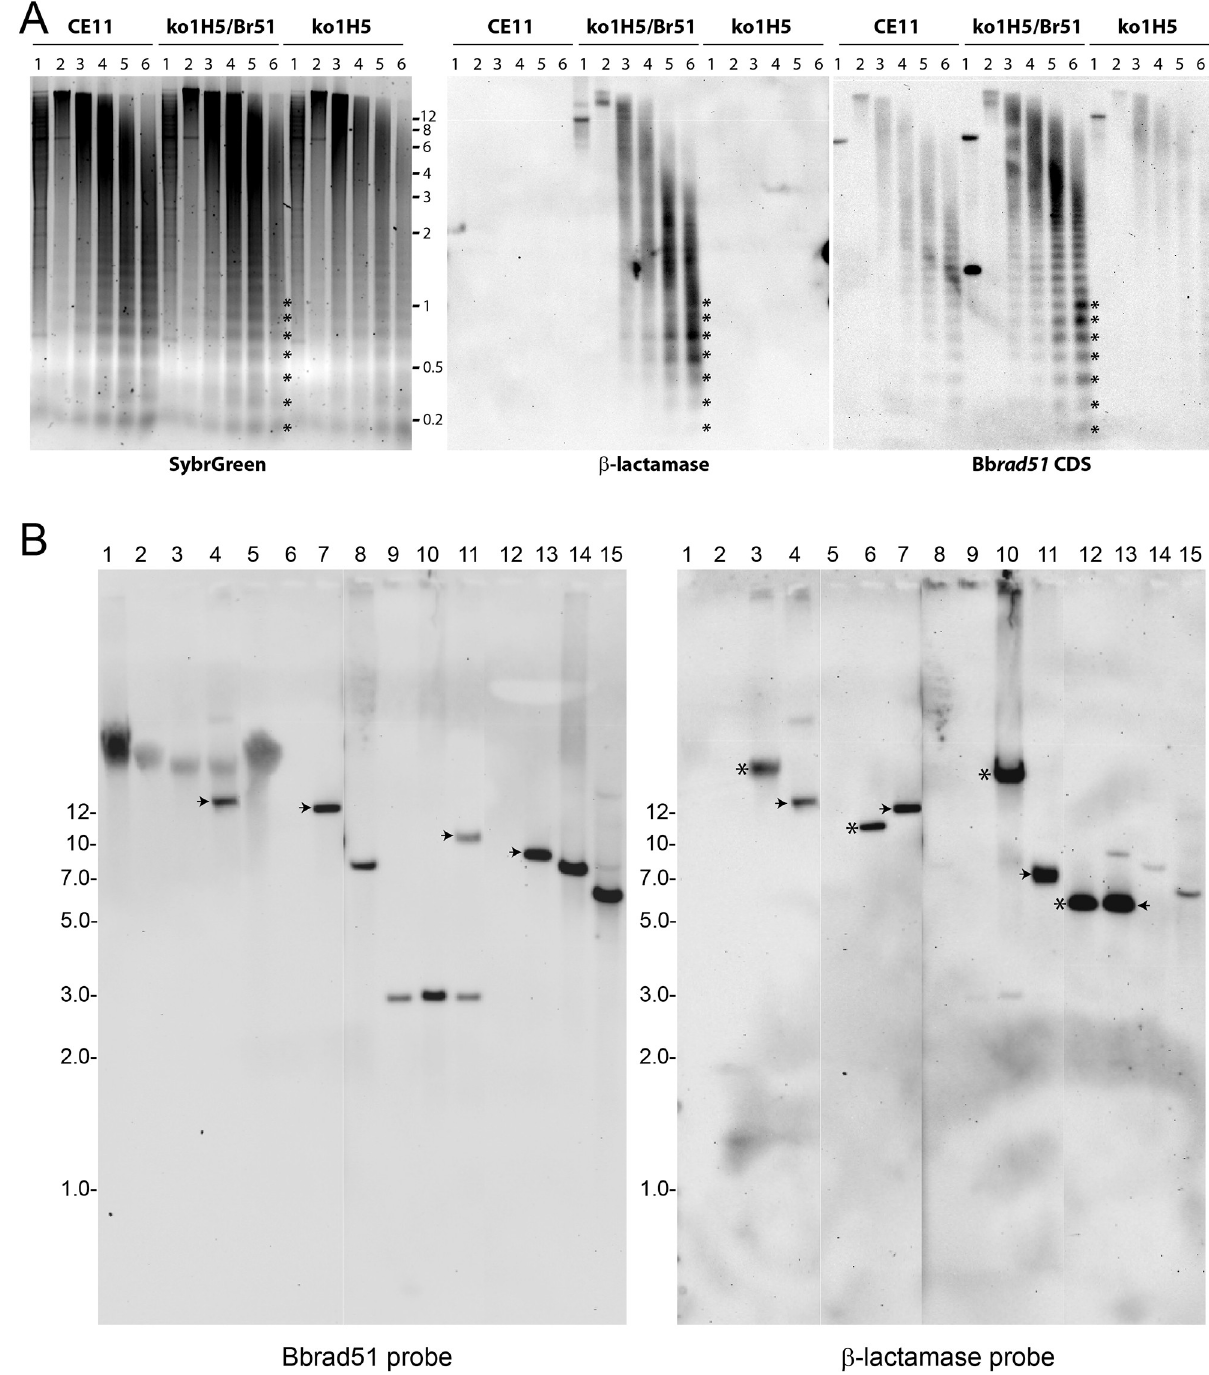
Fig 7. Assembly of BbACc3_Bb rad51 wt into chromatin. Isolated parasite nuclei were subjected to digestion with titrated concentrations of MNase, then Southern-blotted and probed with different sequences. A. (left panel) SybrGreen-stained agarose gel of MNase partially-digested genomic DNAs from B . bovis CE11 wild-type (CE11), ko1 H5/BbACc3_Bb rad51 wt ( ko1 H5/Br51), and ko1 H5 Bb rad51 knockouts ( ko1 H5). Lanes are: (1) PstI-cut purified DNA, (lane 2) chromatin partially-digested with 0 U, (lane 3) 0.0075 U, (lane 4) 0.015 U, (lane 5) 0.03 U, or (lane 6) 0.06 U of MNase prior to